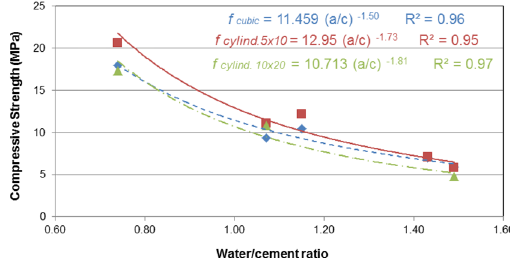
Figure 3. Curves of compressive strength - water/cement ratio for different kinds of specimen, for mortars with compressive strength in the range of 5 to 20 MPa. Table 7. Results of (10 x 20) cm cylindrical specimens.